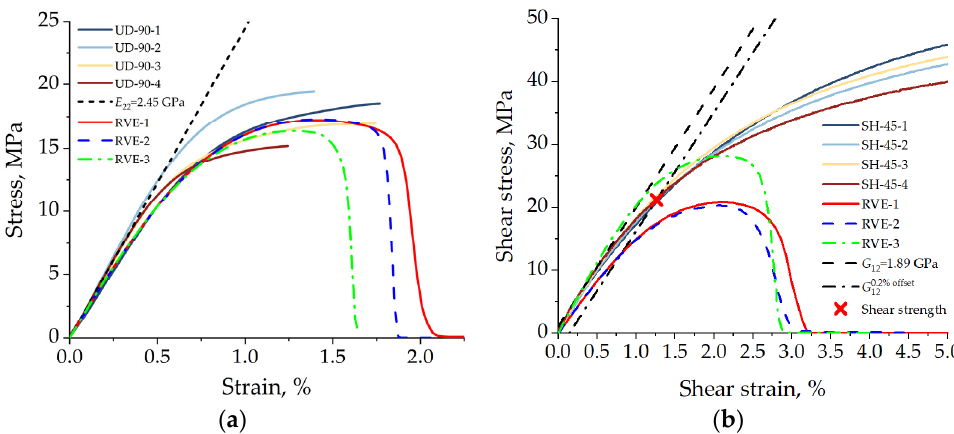
Figure 10. Comparison between the experimental and the numerical results: ( a ) transversally loaded unidirectionally reinforced case, and ( b ) the in-plane shear case.